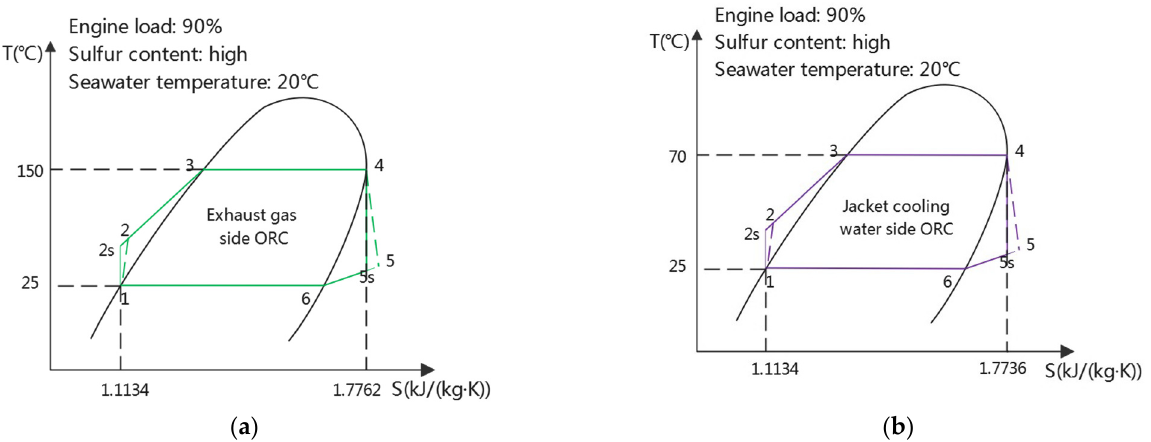
Figure 4. T ‐ S diagram of the ORC subsystem; ( a ) Exhaust gas side; ( b )Jacket cooling water side Figure 4. T-S diagram of the ORC subsystem; ( a ) Exhaust gas side; ( b ) Jacket cooling water